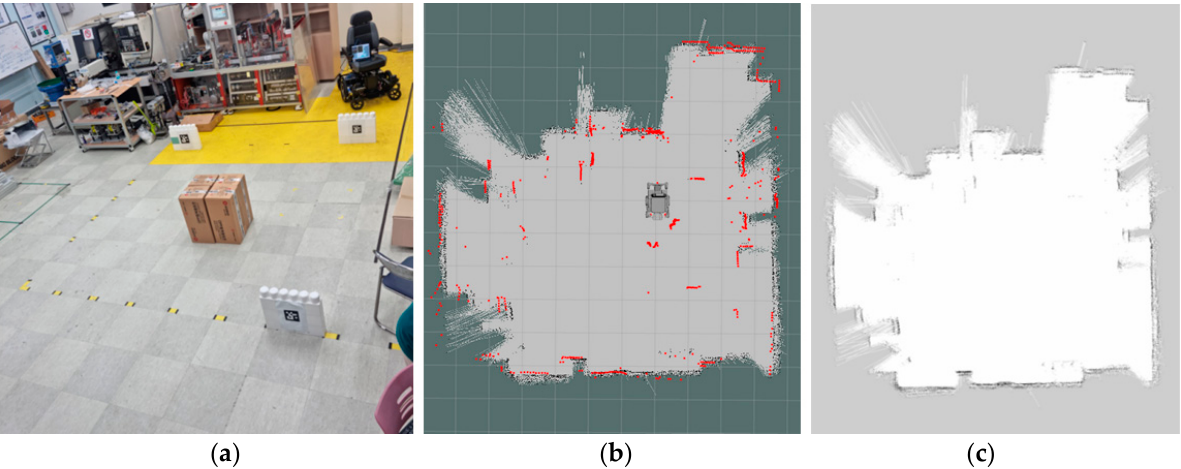
Figure 4. Process of creating a map using SLAM. ( a ) Actual picture, ( b ) SLAM process, and ( c ) screen capture of the completed map.